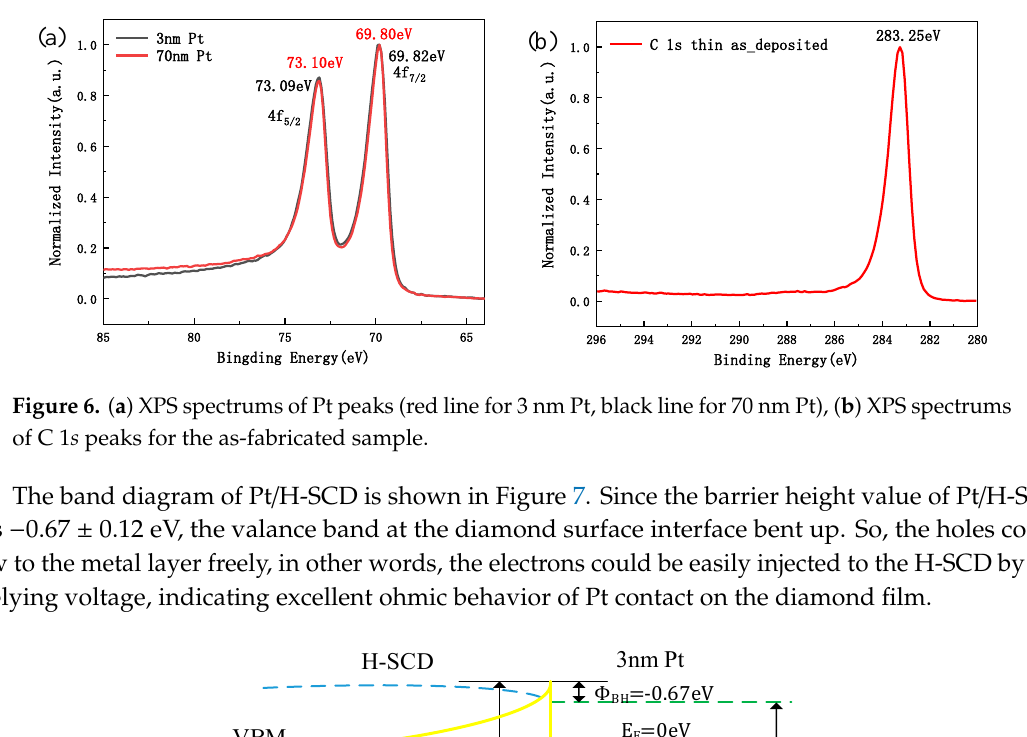
( b ) SEM image of the 3 nm Pt deposited on the diamond film.